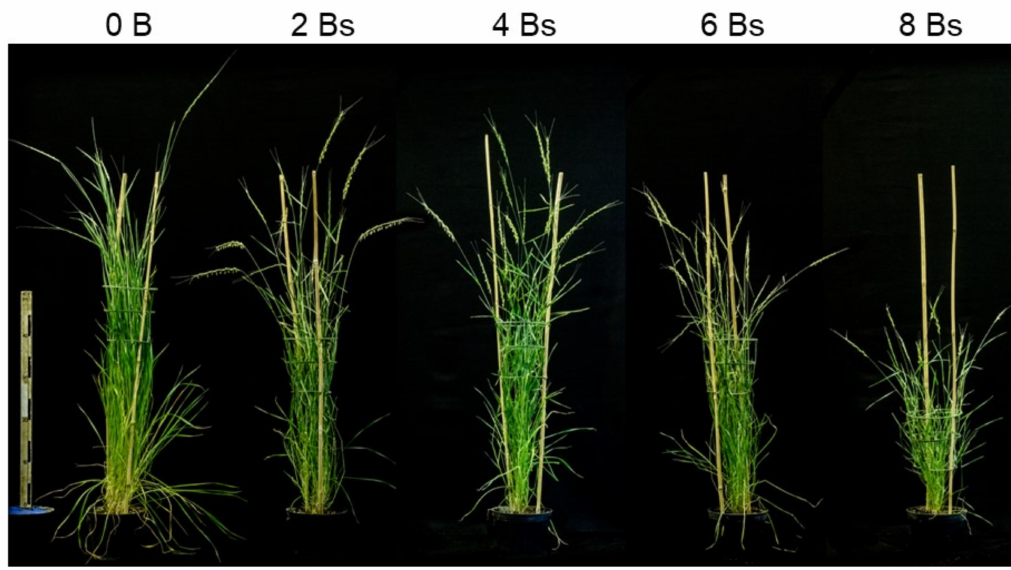
Figure 1. Ae. speltoides plants with an increasing number of B chromosomes. Vegetative growth is a ff ected for plants owing more than 4